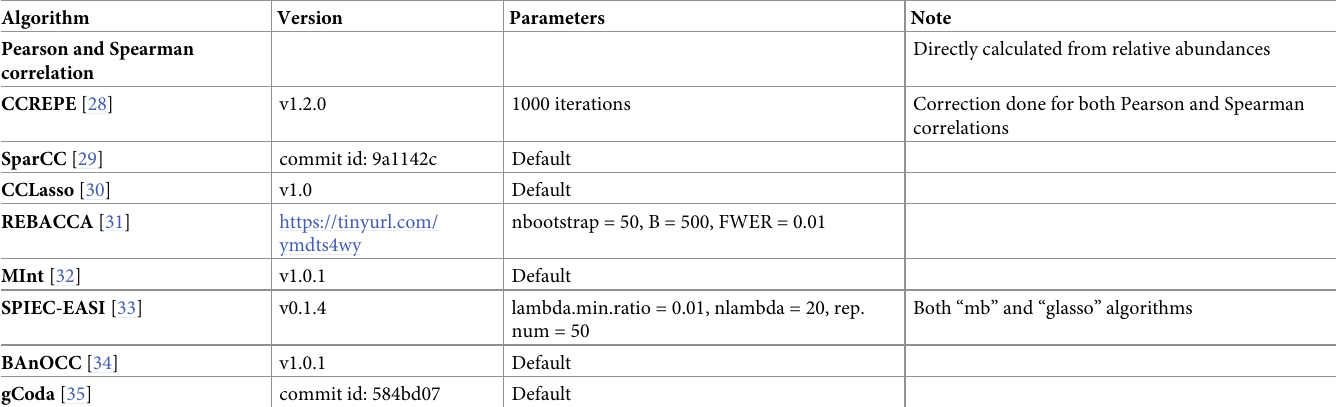
Table 1. Correlation methods